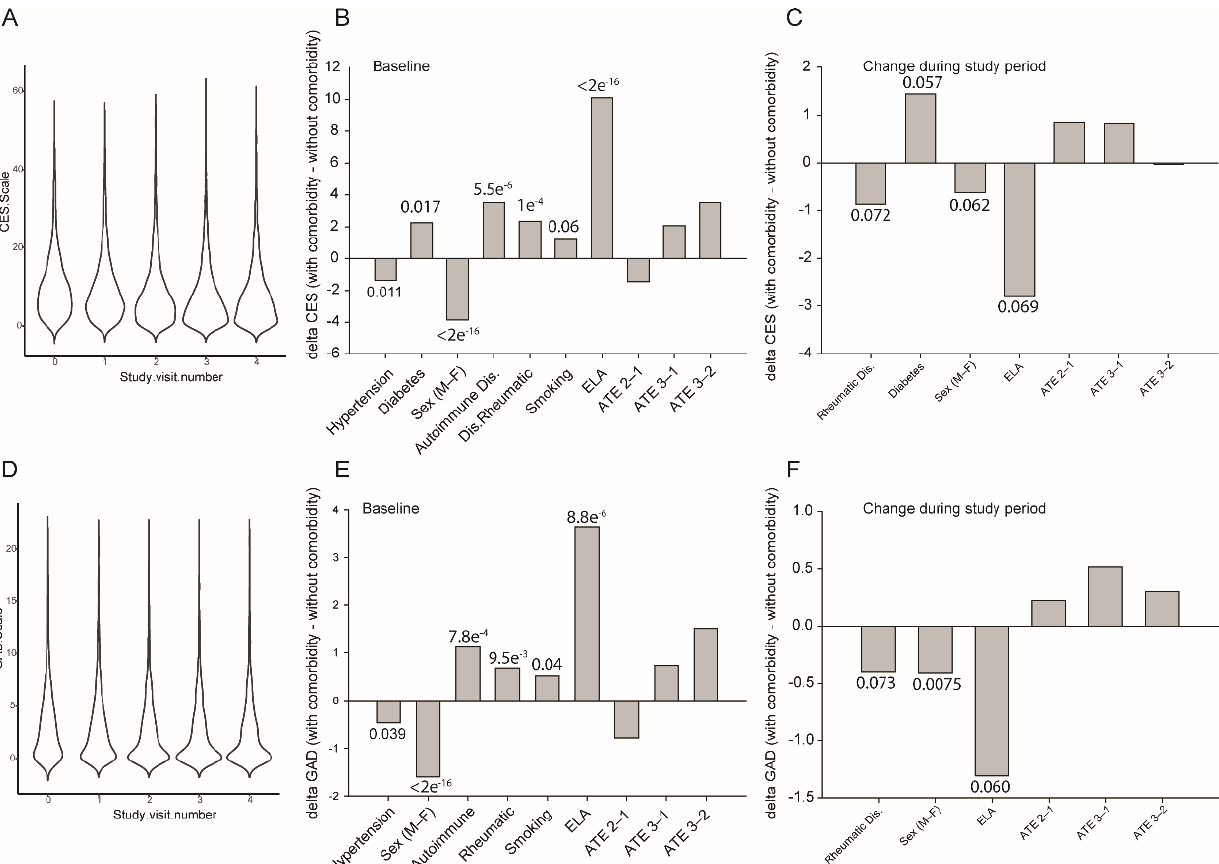
Figure 5. Psychological response to the containment measures during the study period in healthy, asymptomatic, and oligosymptomatic individuals. ( A ) Data density plot for the response to the Center for Epidemiologic Studies Depression Scale (CES-D) for the five experimental visits. ( B ) Significant group differences in CES-D score at the baseline CON-VINCE visit. Full statistical data are included in Supplementary Table S3. Data are from univariate ANOVA analysis, text above/below each bar is the ANOVA p -value. ( C ) Significant group differences in the change in CES-D score between the baseline and last CON-VINCE visit. Full statistical data are included in Supplementary Table S4. Data are from univariate ANOVA analysis, text above/below each bar is the ANOVA p -value. The full multiparameter ANOVA model is described in the Results Section. ( D ) Data density plot for the response to the Generalised Anxiety Disorder-7 (GAD-7) questionnaire for the five experimental visits. ( E ) Significant group differences in GAD-7 score at the baseline CON-VINCE visit. Full statistical data are included in Supplementary Table S4. Data are from univariate ANOVA analysis, text above/below each bar is the ANOVA p -value. ( F ) Significant group differences in the change in GAD-7 score between the baseline and last CON-VINCE visit. Full statistical data are included in Supplementary Table S4. Data are from univariate ANOVA analysis, text above/below each bar is the ANOVA p -value. The full multiparameter ANOVA model is described in the Results